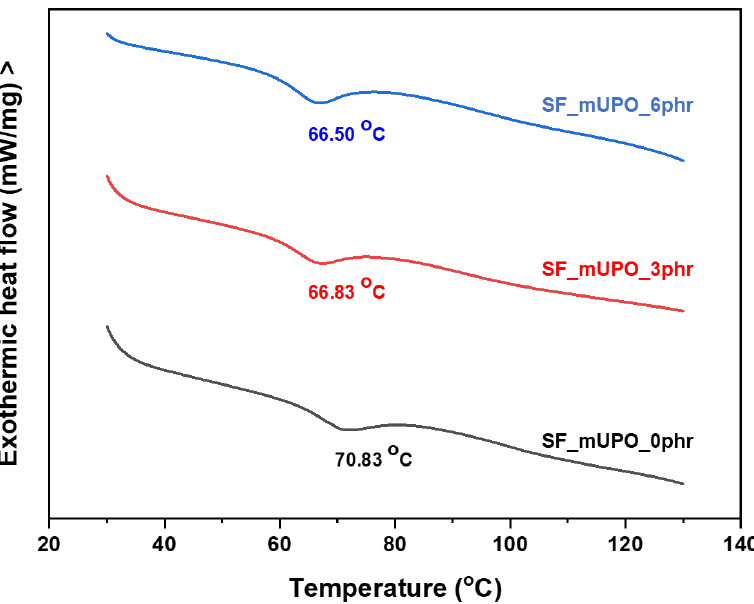
Figure 7. DSC thermogram of non-glutinous starch foam with various mUPO content — 0, 3, and 6 phr.